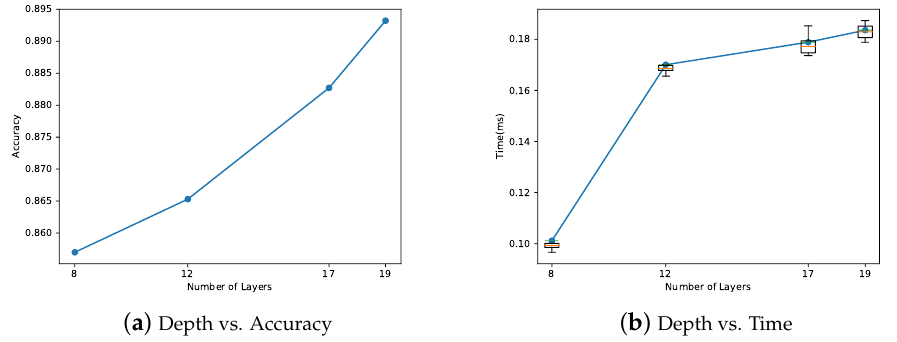
Figure 11. CNN Depth vs. Accuracy and Execution Time (CIFAR-10). When the depth is increased from 8 to 19, the execution time increases by more than 1.8 × , but the accuracy enhances by only 3.6%. From these results, we observe that considering only the depth of a CNN for adaptation is less effective than our approach for robust real-time image classification via systematic time vs. accuracy trade-offs. The hyper-parameter values used to design the CNNs with different depths are specified in this